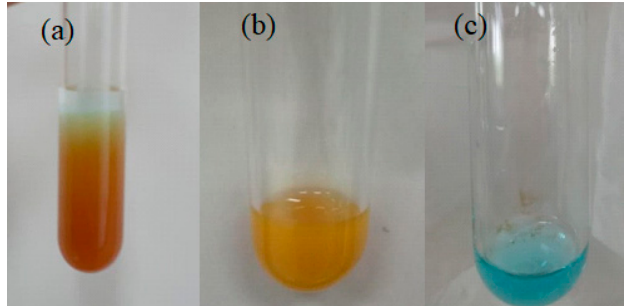
Figure 4. Results of Benedict’s test of ( a ) glucose solution, ( b ) filtrate of NIZ after washing, and ( c ) filtrate of IZ after washing.